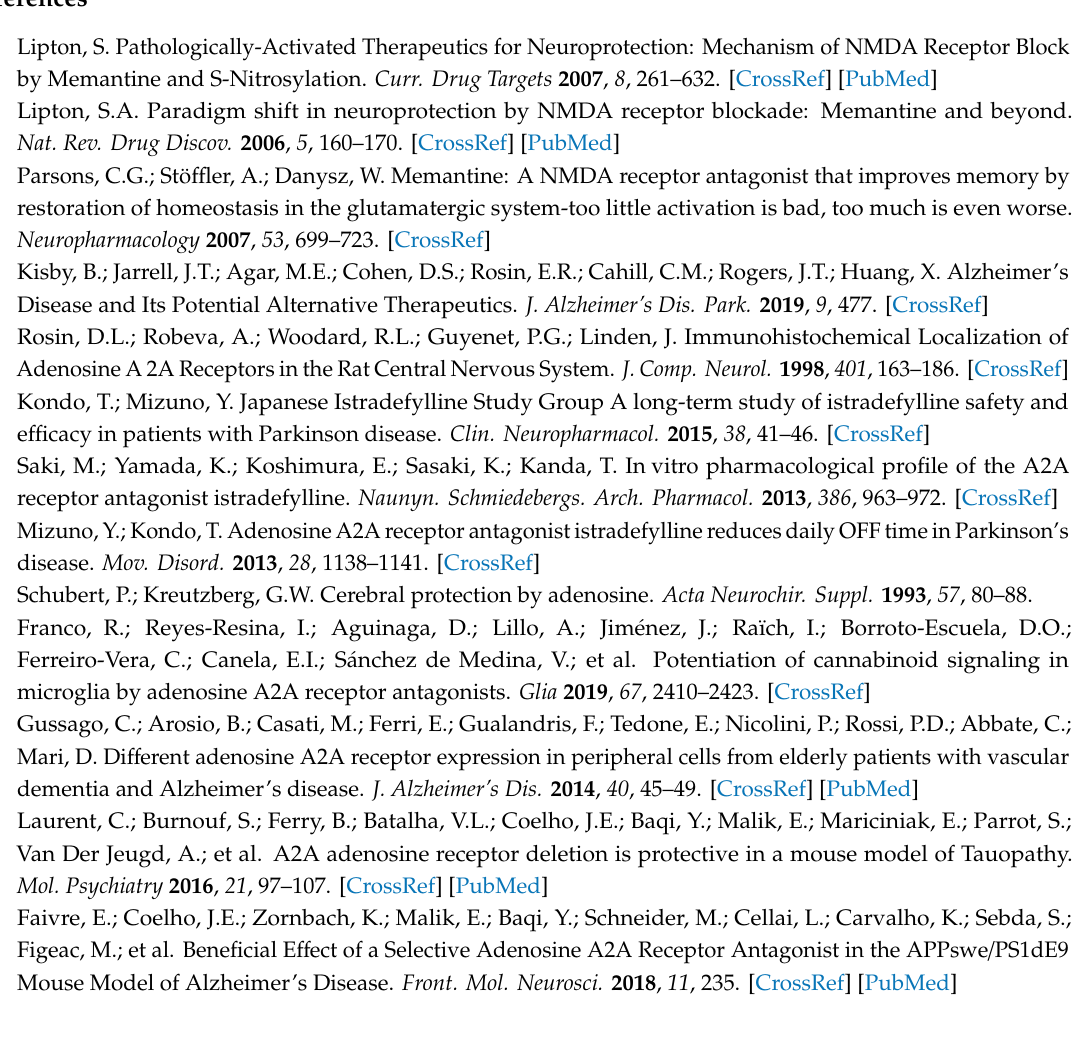
Figure S1: Functional signaling of A 2A and NMDA receptors in HEK-293T